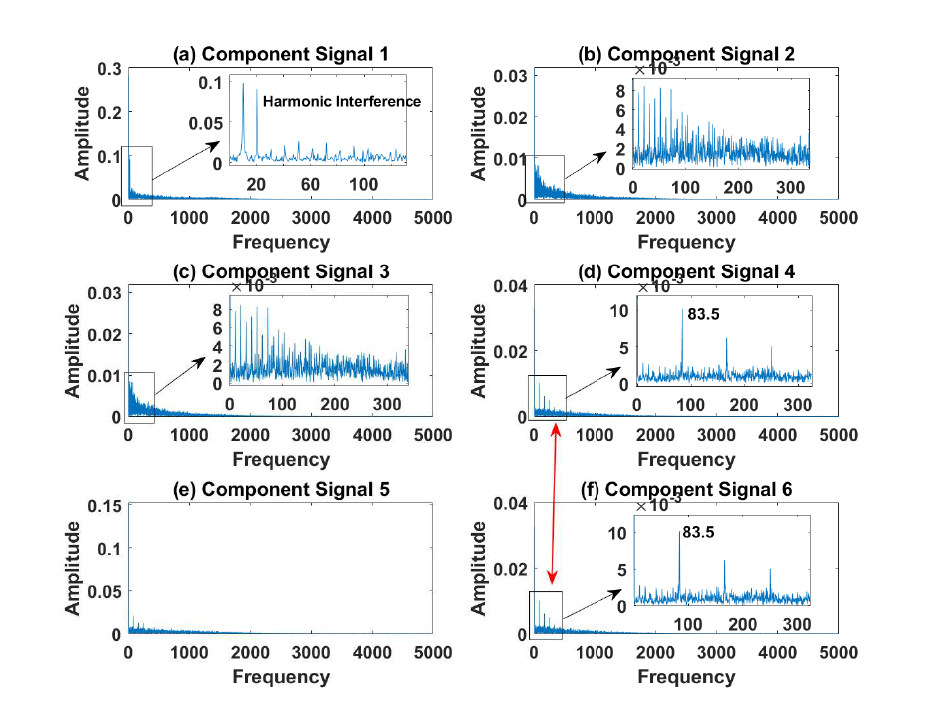
Figure 12. Decomposition results of SVDP with m = 16 and J = 3: ( a – f ) envelop of 1st to 6th subcomponents, respectively.